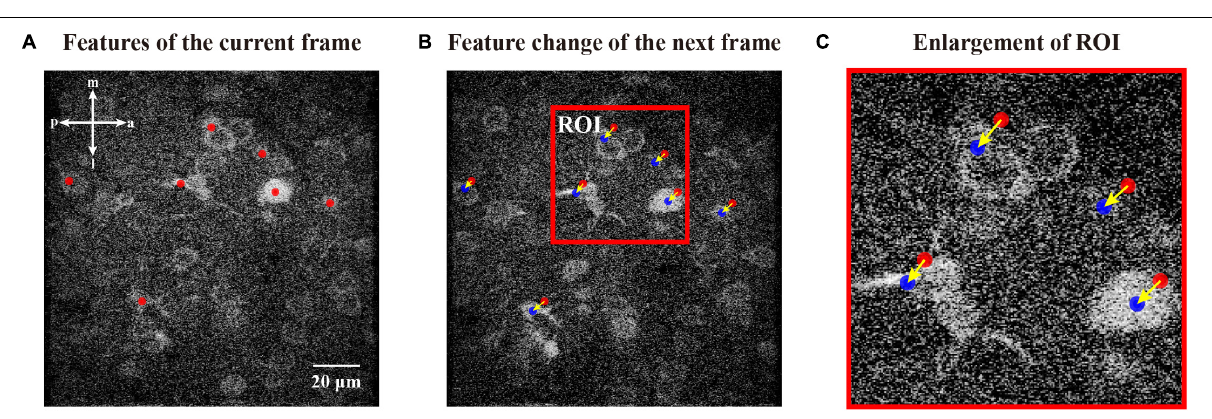
FIGURE 5 | Updating features in a consecutive mode. (A) Features of current frame marked by red dots. (B) Features of the next frame updated from features of the current frame. We indicate features of the next frame with blue dots and those of the current frame with red dots. (C) Enlargement of the respective ROI in panel (B) , i.e., the change flow of coordinates during this iteration. The arrows indicate the movement